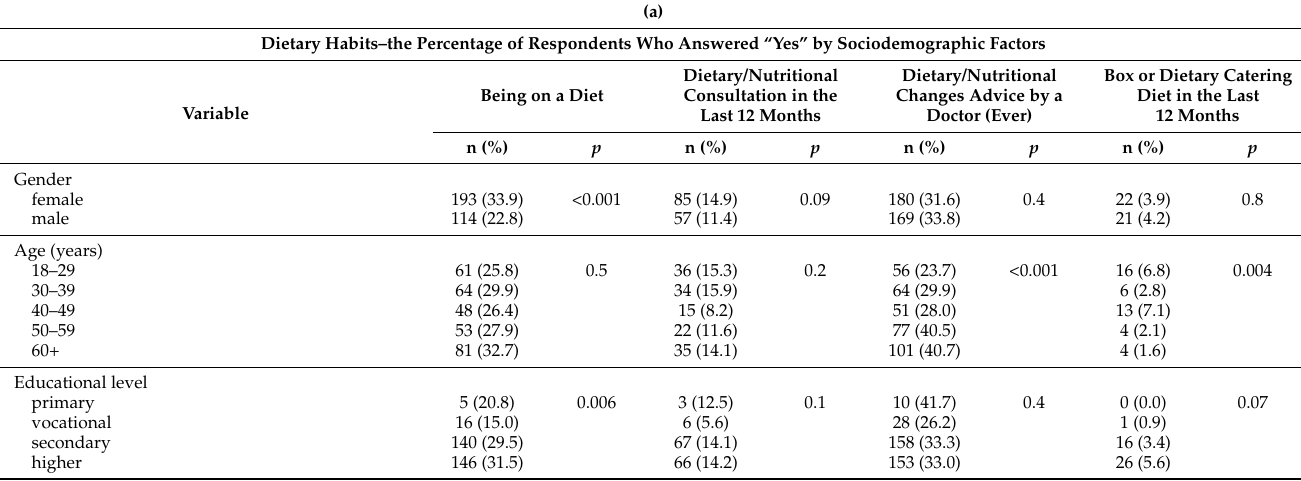
Table 3. Respondents’ dietary habits by sociodemographic and lifestyle variables (n = 1070).